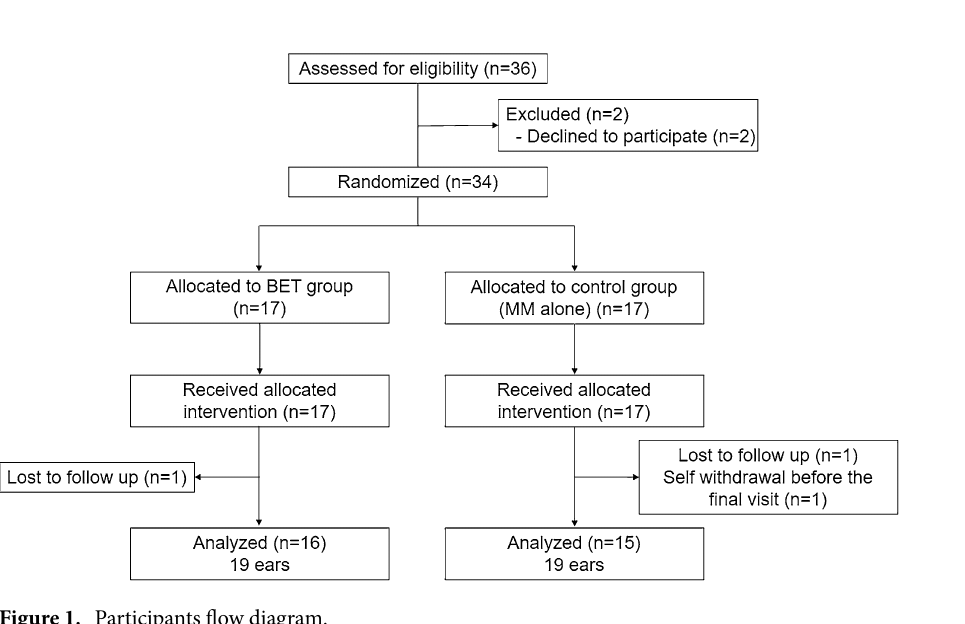
Figure 1. Participants flow